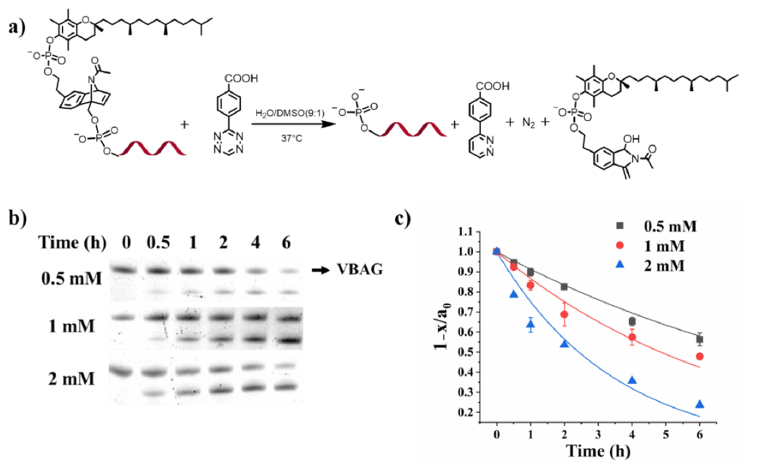
Figure 1. ( a ) Bioorthogonal bond-cleavage reaction between vitamin E-benzonorbonadiene-caged antisense strand oligonucleotide (VBAG) and tetrazine; ( b ) the representative 20% denaturing PAGE gel monitoring the reaction with 1 μ M vitamin E-benzonorbonadiene-caged oligonucleotide and excess tetrazine with different concentration (0.5 mM, 1 mM, 2 mM) in mixed solvents (H 2 O:DMSO = 9:1); ( c ) the quantitative analysis and fitted curves of the PAGE gel results. 1 − x/a0 is the ratio of the unreacted vitamin E-benzonorbonadiene-caged oligonucleotide, and the data were fitted as single-exponential curves using Origin 8.0 software.